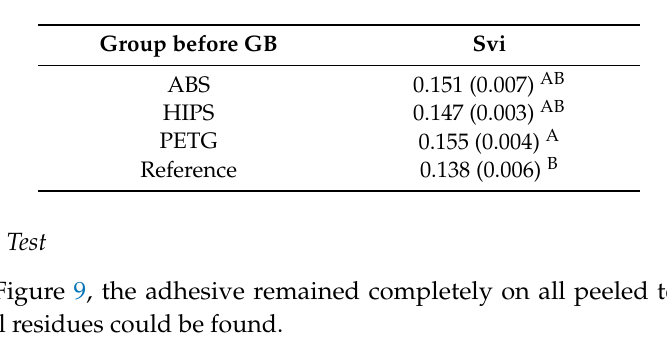
Table 3. Mean (standard deviation) Svi value of each group before GB. The results of statistical analysis were shown by superscript letters. The groups with the same superscript letter had no statistical difference.